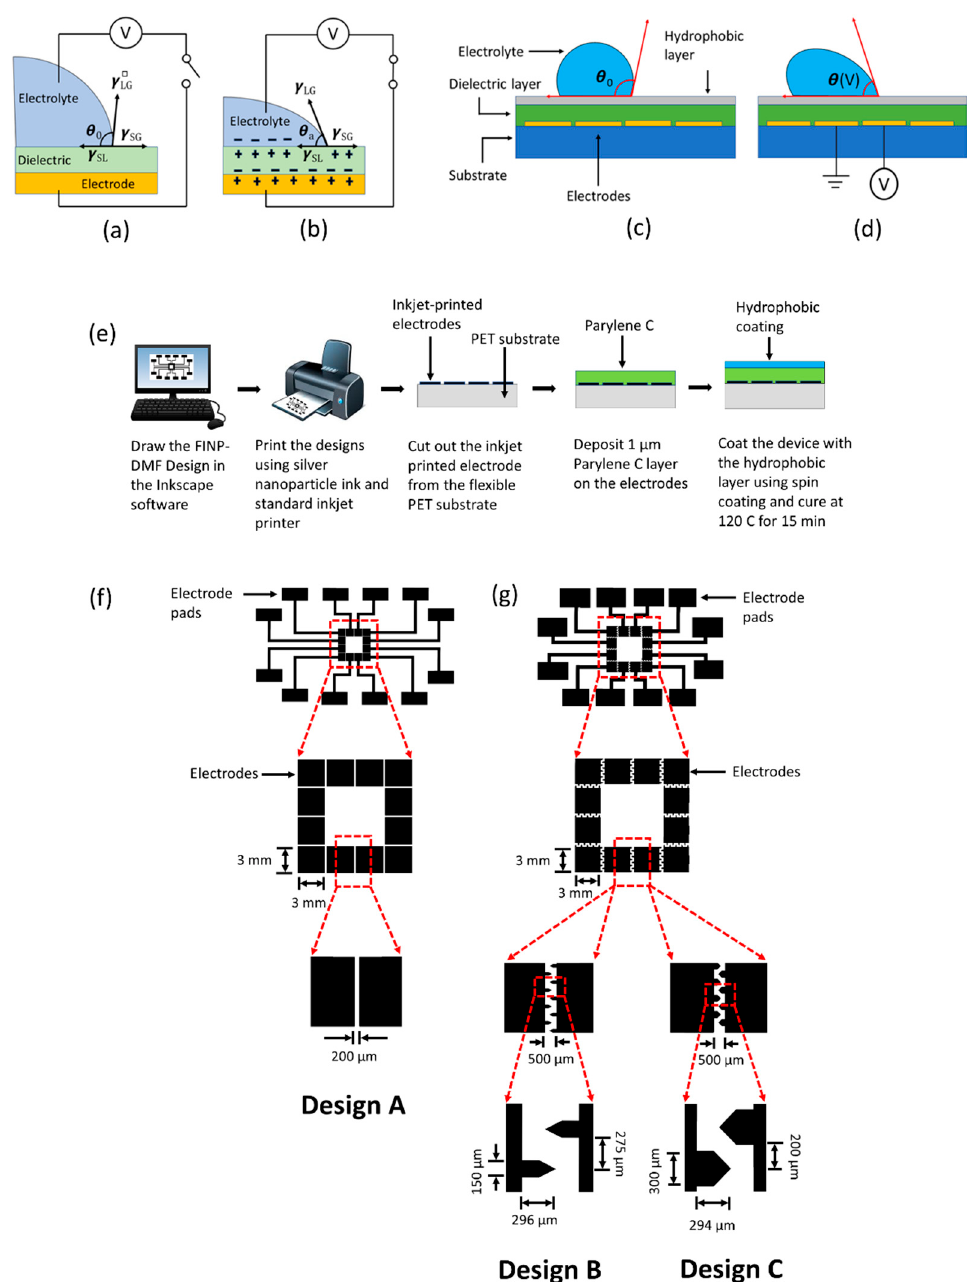
Figure 1. ( a ) A droplet of an electrolyte sitting on an electrowetting on dielectric (EWOD) device. The dielectric layer prevents spontaneous charge accumulation at the surface at zero voltage. ( b ) When a voltage is applied, charges accumulate at the interfaces, which decreases the surface tension of the solid-liquid interface and the contact angle of the liquid. ( c , d ) Principle of droplet motion on the EWOD device. When the droplet is located on the boundary between the actuated and non-actuated electrode, the electrowetting force is applied on the contact line located above the actuated electrode, and the capillary force is exerted on the contact line located on the lyophobic region. The resultant force is located towards the actuated electrode, and the droplet moves towards the actuated electrode. ( e ) The fabrication process of the flexible inkjet-nanoparticle-printed digital microfluidic (FINP-DMF) platform. Electrode designs are drawn in the Inkscape software and then printed on a flexible PET substrate using a commercial office printer. The printed devices are then coated with a 1 µ m